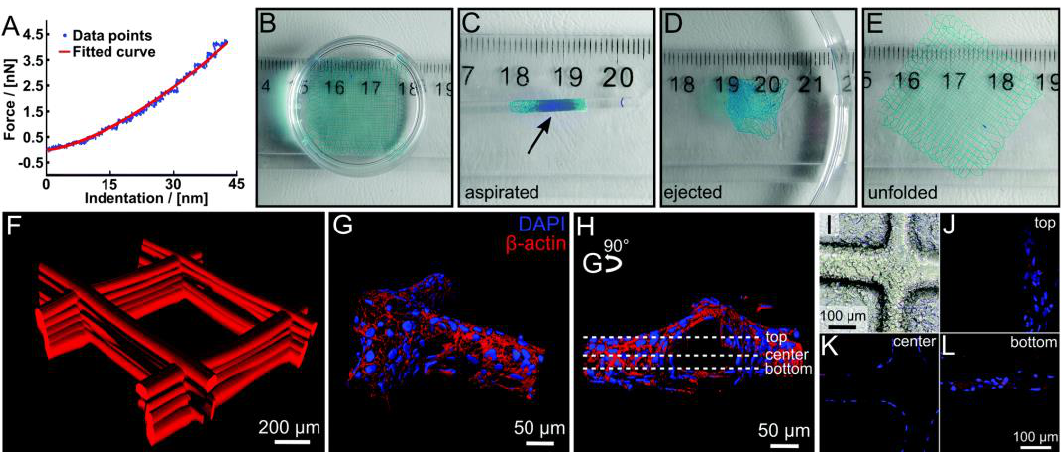
Figure 3. ( A ) Example of a force–distance curve for a swollen scaffold with a fitting curve using the Hertz model. ( B – E ) Illustration of the robust character of the hydrogel scaffolds. The swollen scaffolds ( B ) can be aspirated in a glass pipette (inner diameter 1.35 mm) ( C ) and ejected again repeatedly ( D ) without any visual damage to the scaffold, which unfolds ( E ) again by itself. Scaffolds were functionalized with DY-647P1-maleimide for better visualization. ( F ) Confocal microscope image of a fluorescently labeled hydrogel scaffold with 500 mm fiber spacing. ( G – L ) HEK293 cells were grown on hydrogel scaffolds functionalized with peptide (NH2-CGGGRGDS-COOH). ( G , H ) Cells were stained with cytoskeletal marker protein b-actin (red) and DAPI (nucleus, blue). Three-dimensional surface-reconstruction of HEK293 cells attached to scaffold (Imaris 7.6 software). ( I ) Phase-contrast image of seeded scaffold with HEK293 cells are attached along and around the scaffolds. ( J – L ) Representative images of one hydrogel filament within the whole scaffold from bottom, center, and top are shown, positions marked in ( H ). Video 3 (ESI†) provides a demonstration of aspiration and ejection, while Video 4 (ESI†) shows (G,H) in greater detail. Reproduced with permission from D. Nahm, F. Weigl, N. Schaefer, A. Sancho, A. Frank, J. Groll, C. Villmann, H. Schmidt, P. D. Dalton and R. Luxenhofer, Mater. Horiz., 2020, 7, 928-Published by The Royal Society of Chemistry.